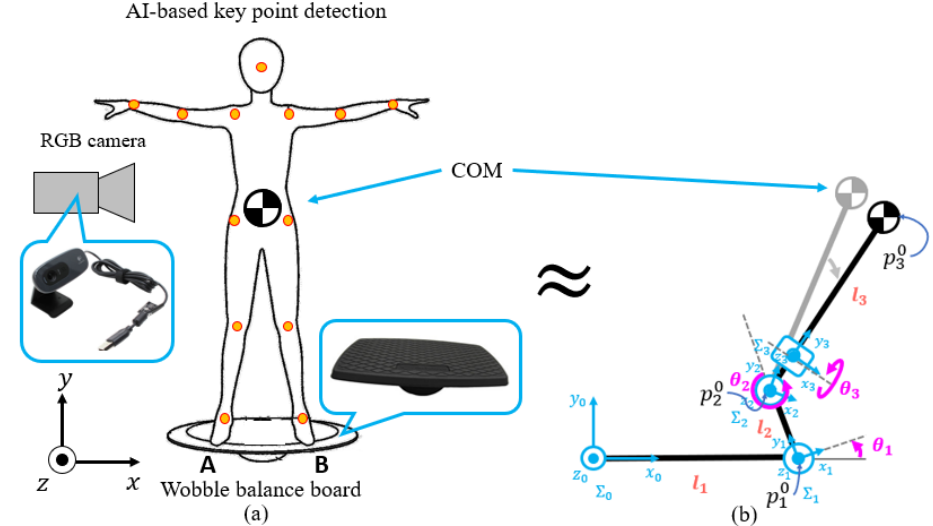
Figure 1. ( a ) An overview of experimental environment, system, and ( b ) a definition of variables for an equivalent model, which is expressed as an inverted pendulum on wobble